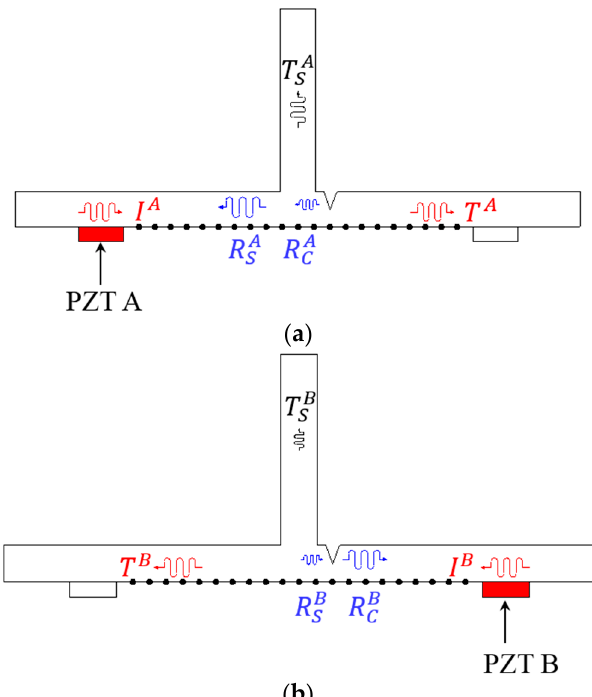
generated from PZT A and T